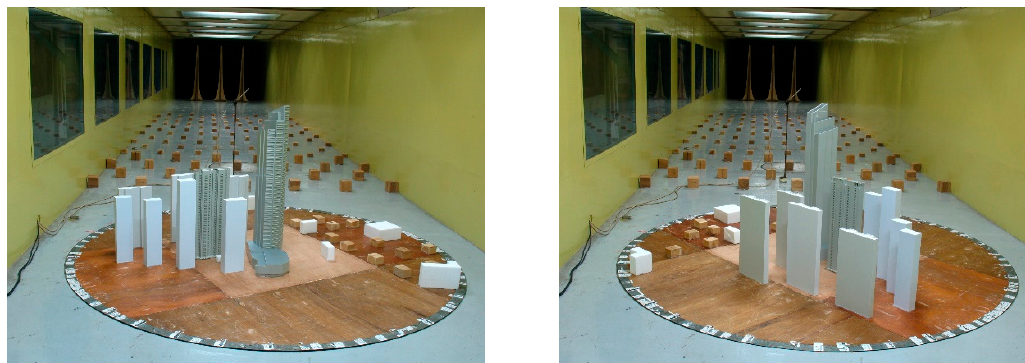
Figure 4. The rigid building model with existing surrounding conditions mounted in the wind tunnel lab of Shantou University from two different perspectives.